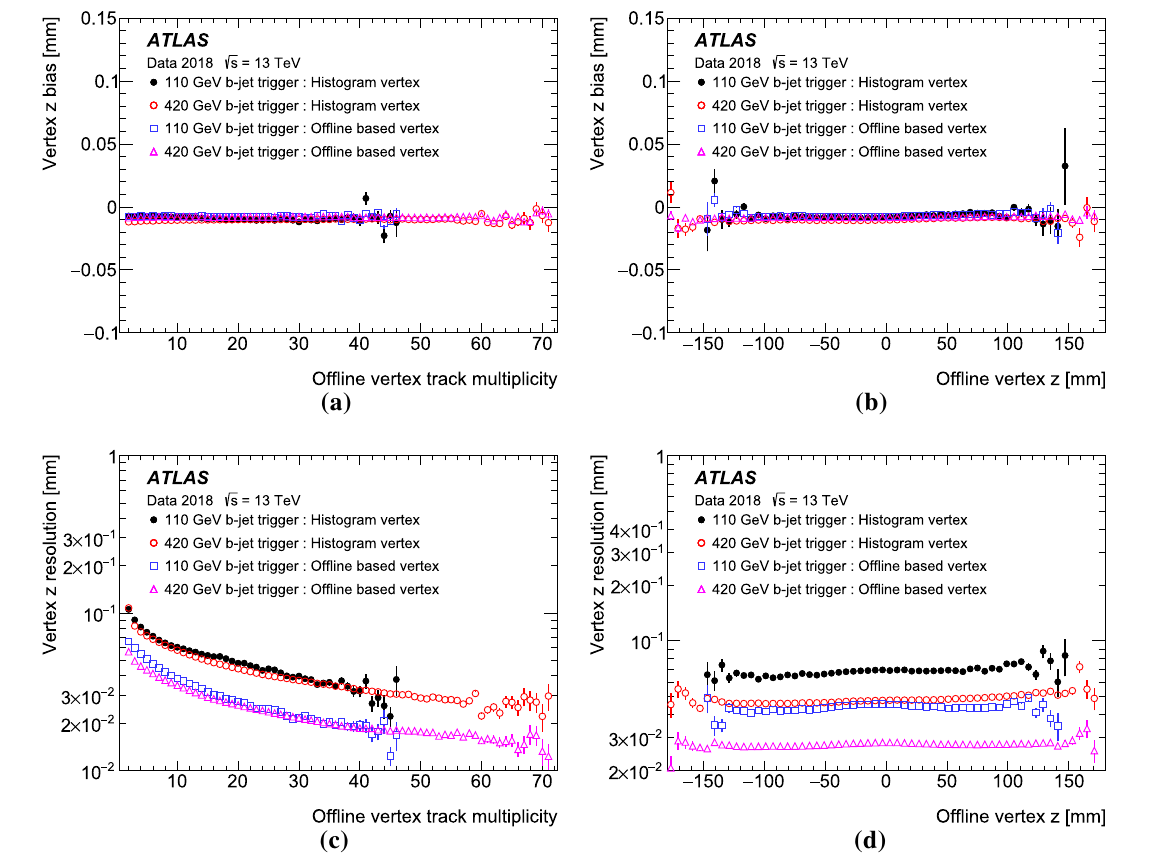
Fig. 44 Thebiasandresolutioninthe z positionalongthebeam linefor the trigger vertex reconstruction for intermediate and high E T b -jet trig- gers. Shown are the bias ( a ), and resolution ( c ) with respect to the mul-